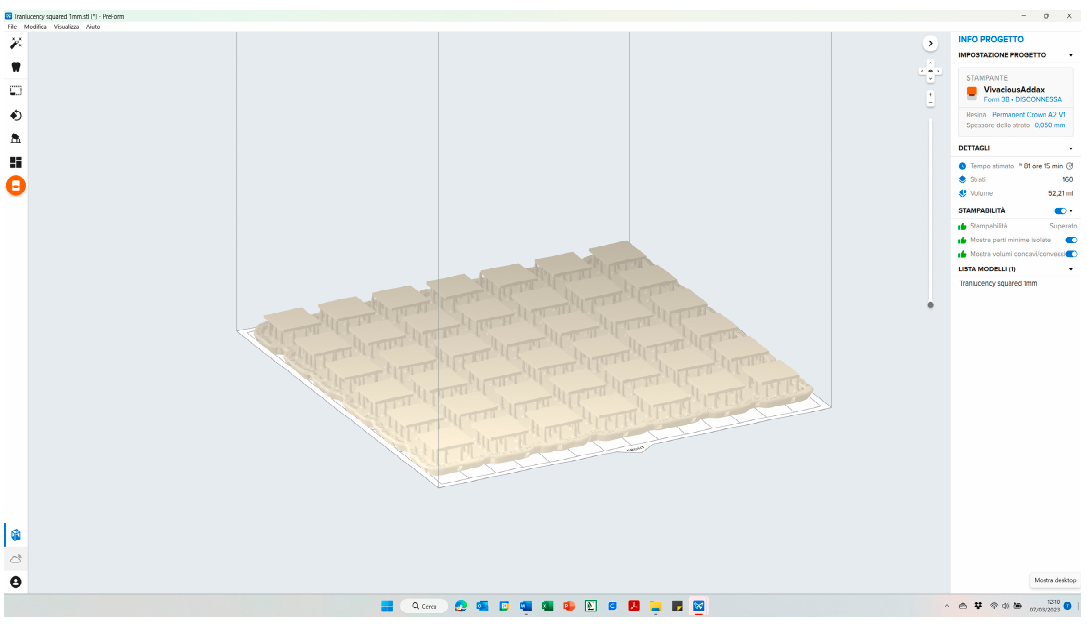
Figure 3. Specimens’ automatic supports calculation and slicing was performed in PreForm software.